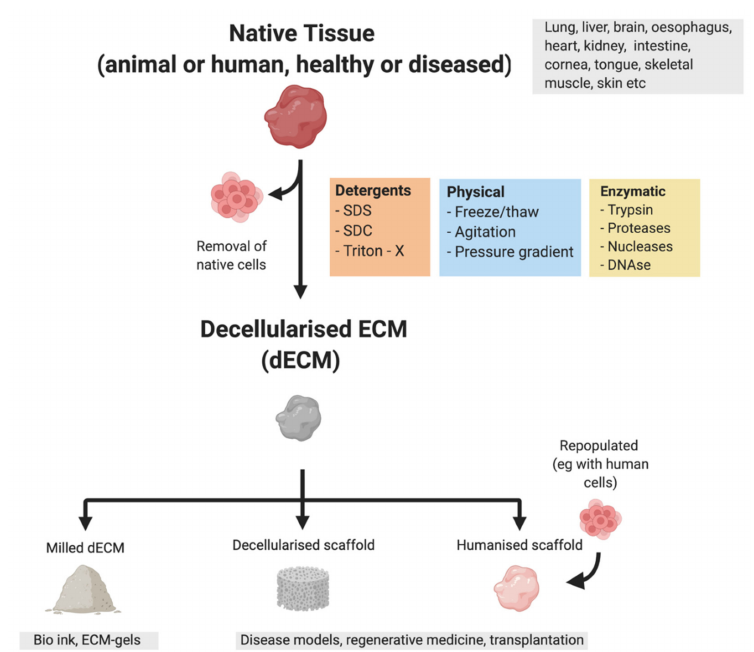
Figure 1. Most commonly used methods of decellularization and uses of decellularized ECM. Figure was created using BioRender (https://app.biorender.com, accessed 7 October